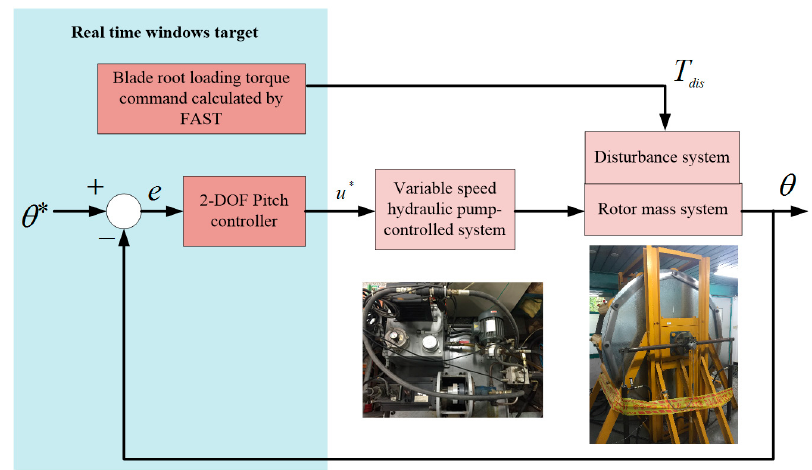
Figure 7. Hardware in the loop for wind turbine pitch control system. Energies 2016 , 9 , 791